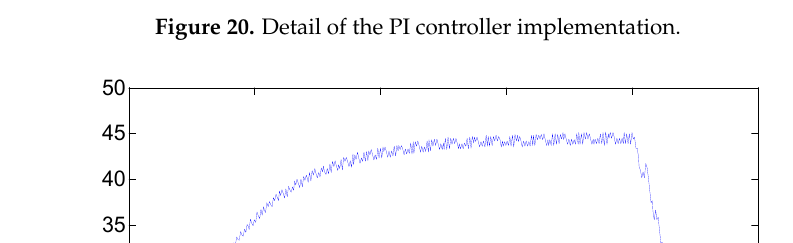
Figure 21. Wheel velocity profile during a closed loop operation.